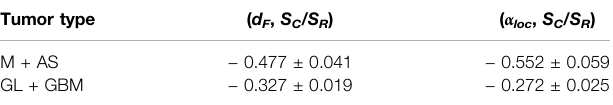
TABLE 4 | Trend parameters for data points in ( d F , S C / S R ) and ( α loc , S C / S R ). Tumor type